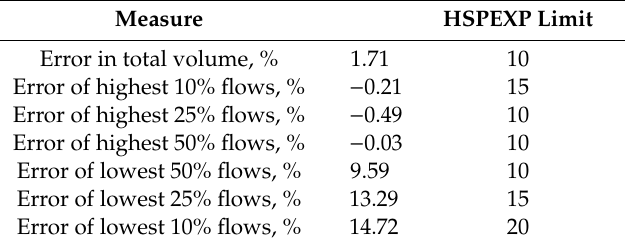
Table 7 . HSPF model performance through HSPEXP+ 2.0. Table 7. HSPF model performance through HSPEXP + 2.0.